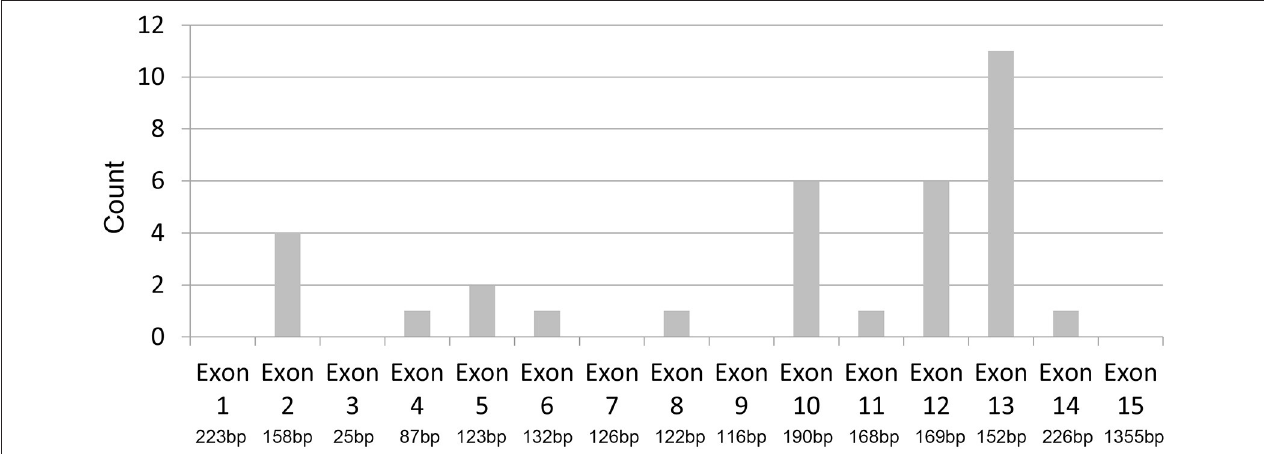
antigen level. In our hands, the free protein S antigen